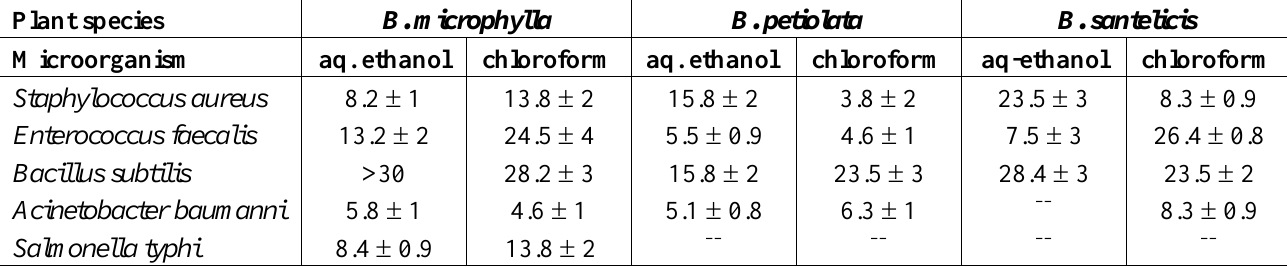
Table 1 . Antimicrobial activity of aqueous ethanol and chloroform extracts from three Baccharis species from Northern Chile (diamater of inhibition zone in mm) * Plant